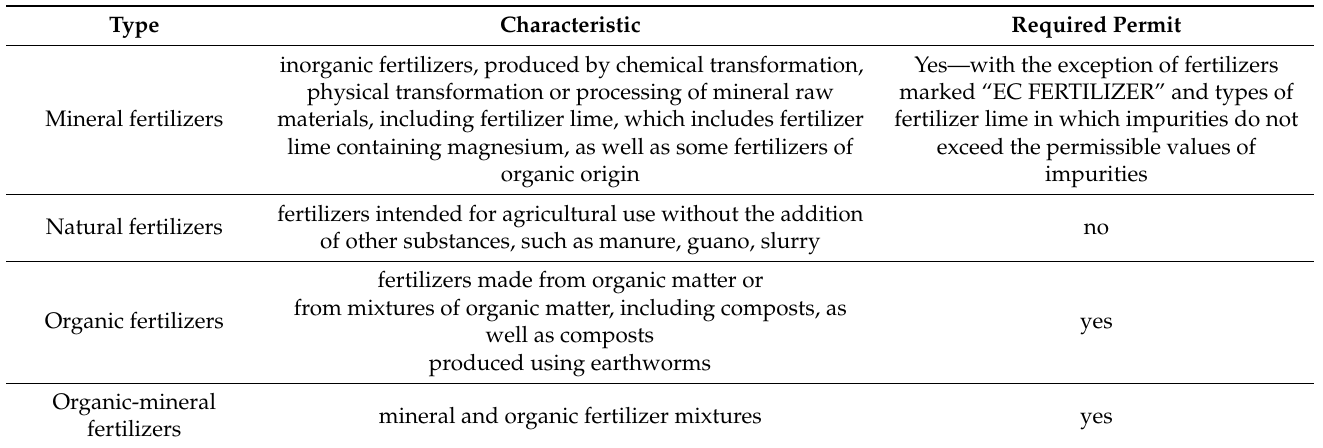
Table 5. Fertilizer groups with an indication of the need for a permit (own elaboration based on